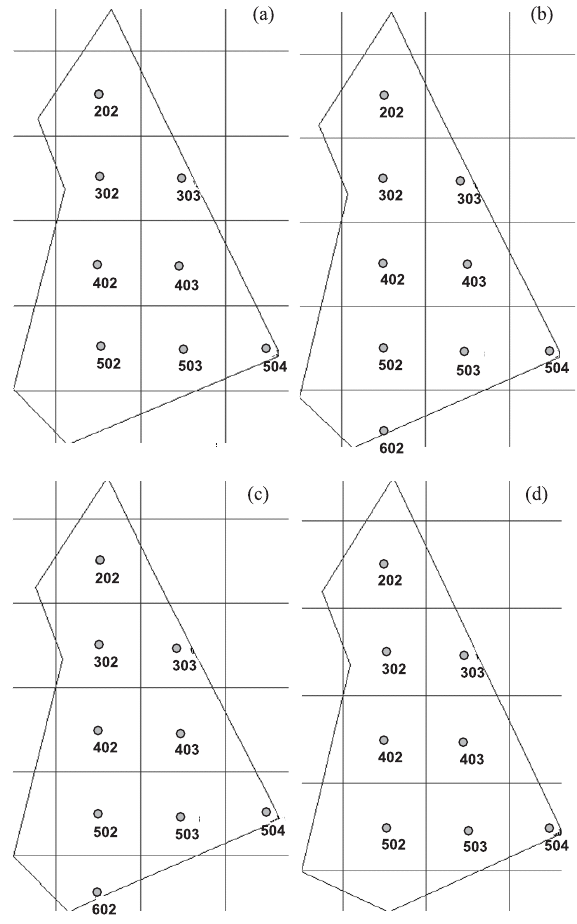
Figura 1. Polígonos, quadrículas de 2 ha e respectivos pontos centrais criados no CR-Campeiro ® oriundos de levantamentos planimétricos com auxílio de Estação Total (a) e GPS de navegação (b) GPS 48, (c) GPS 49 e (d) GPS